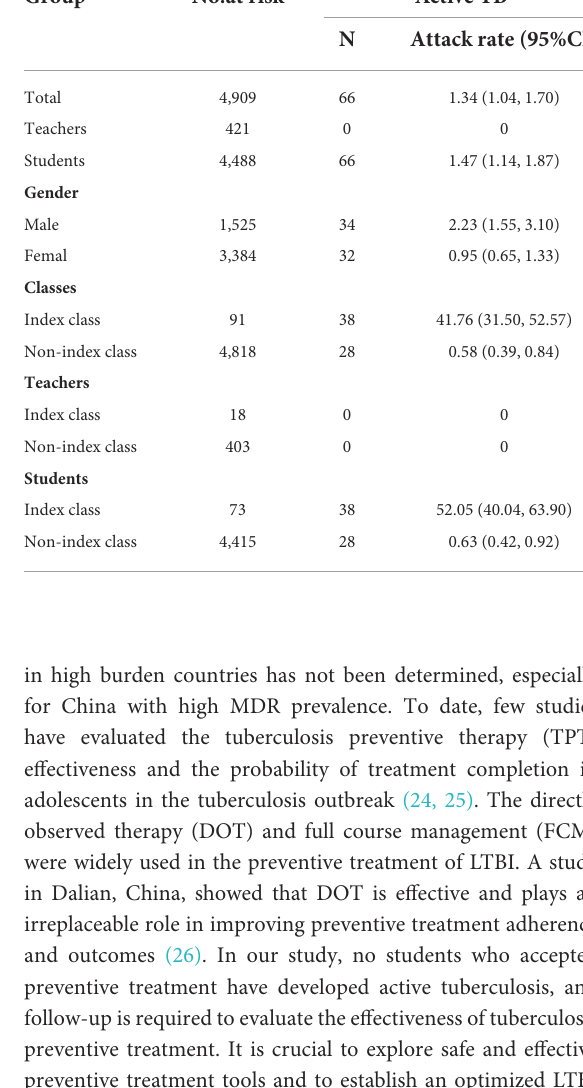
TABLE 2 Demographic and clinical characteristics of the patients in a university, Jiangsu, China. Characteristics